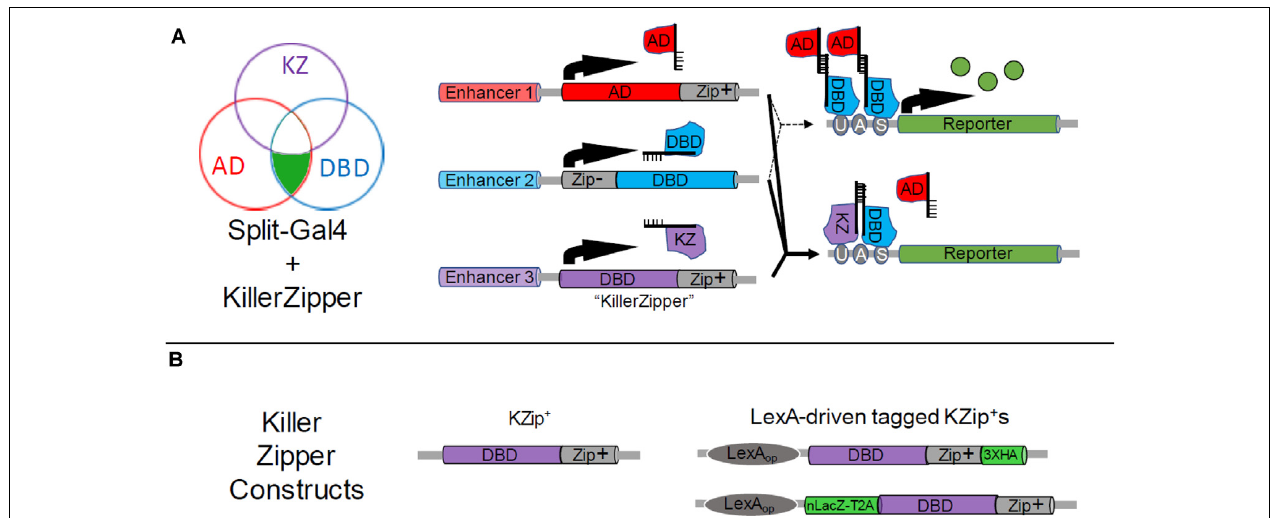
FIGURE 3 | Restricting Split Gal4 expression using the Split Gal4 repressor, KZip + . (A) As shown in the Venn diagram (left), the Killer Zipper (KZip + ) can be used to exclude Split Gal4 activity from cells within an intersection. Where the activity of the enhancer used to drive KZip + expression (Enhancer 3, purple circle) overlaps with that of the enhancers used to drive expression of the Zip + -AD (red circle) and Zip − -Gal4DBD (blue circle) constructs (see Figure 1B ), Split Gal4 activity is repressed and no reporter expression is observed. This is illustrated in bottom-right panels, where the solid lines indicate the expression of all three constructs. Reporter expression is restricted to only that part of the intersection where Zip + -AD and Zip − -Gal4DBD alone are expressed (upper right-hand panels; dotted lines). (B) Available Killer Zipper constructs include a basic KZip + that can be expressed under the control of a specific enhancer (left) and several “universal” constructs that express KZip + constructs under the control of LexA drivers. Two of the latter are shown (right), one of which bears a hemagglutinin (HA) tag and the other of which co-expressed a nuclear LacZ molecule. HA and nLacZ permit the detection of KZip + expression in cells by